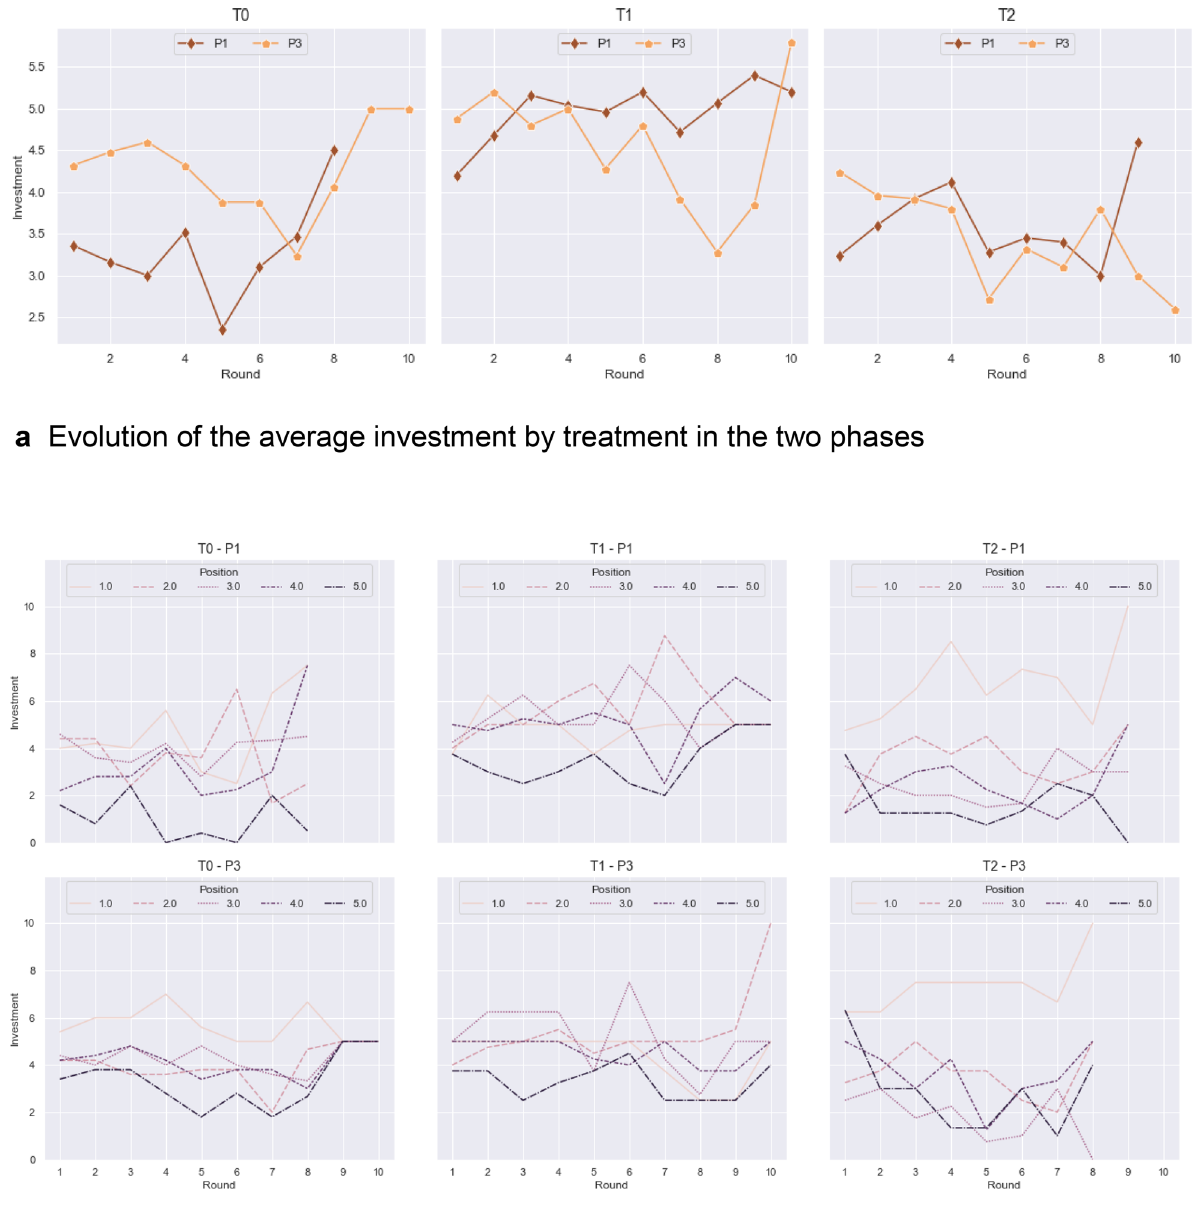
Figure 6. Evolution of the average investment in the two phases by treatment and depending on